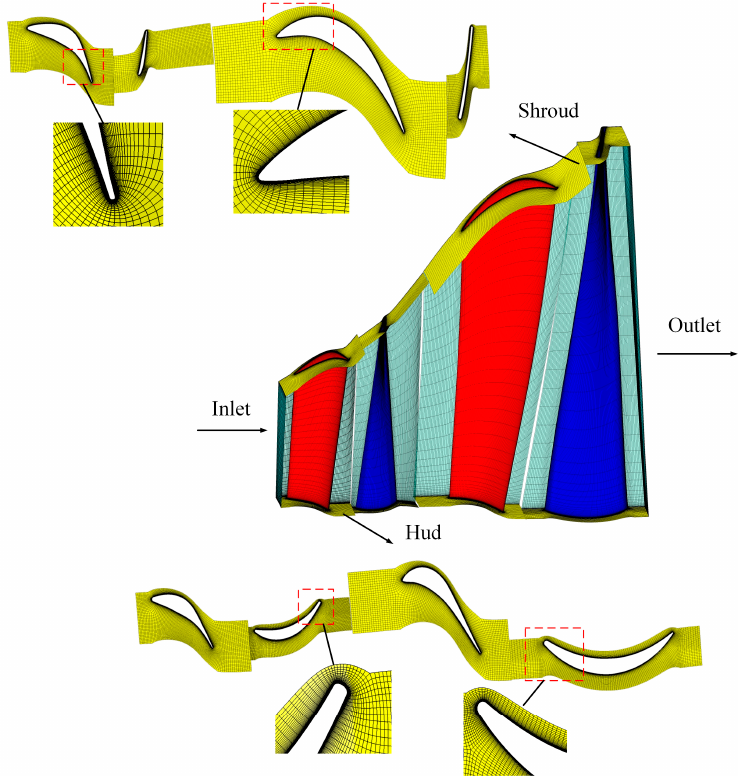
Figure 2. Last two stages of the structure grid and local grid enlargement in the low-pressure cylinder of steam